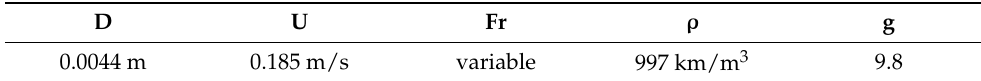
Figure 1. Rosette-type diffuser, computational domain, and mesh: (( a ) shows a schematic of the diffuser, ( b ) is a computational grid, and ( c ) is a refined mesh near the discharge port). Table 1. Model